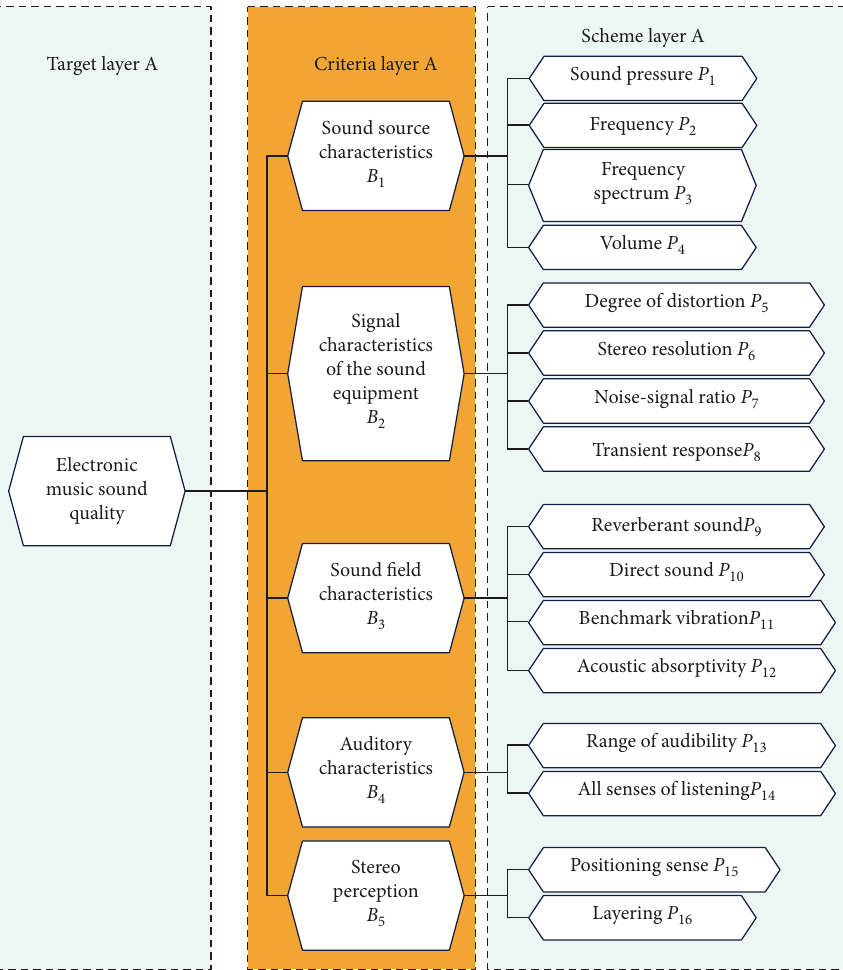
Figure 5: Music audio analysis